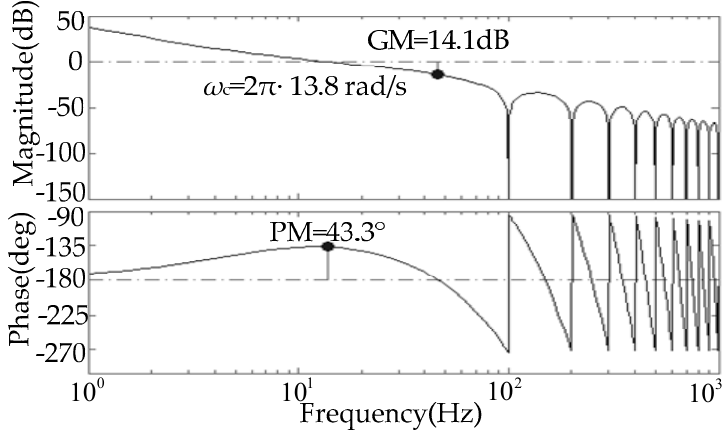
Figure 3. Bode plot of the open-loop transfer function of CF-PLL; N = 100.